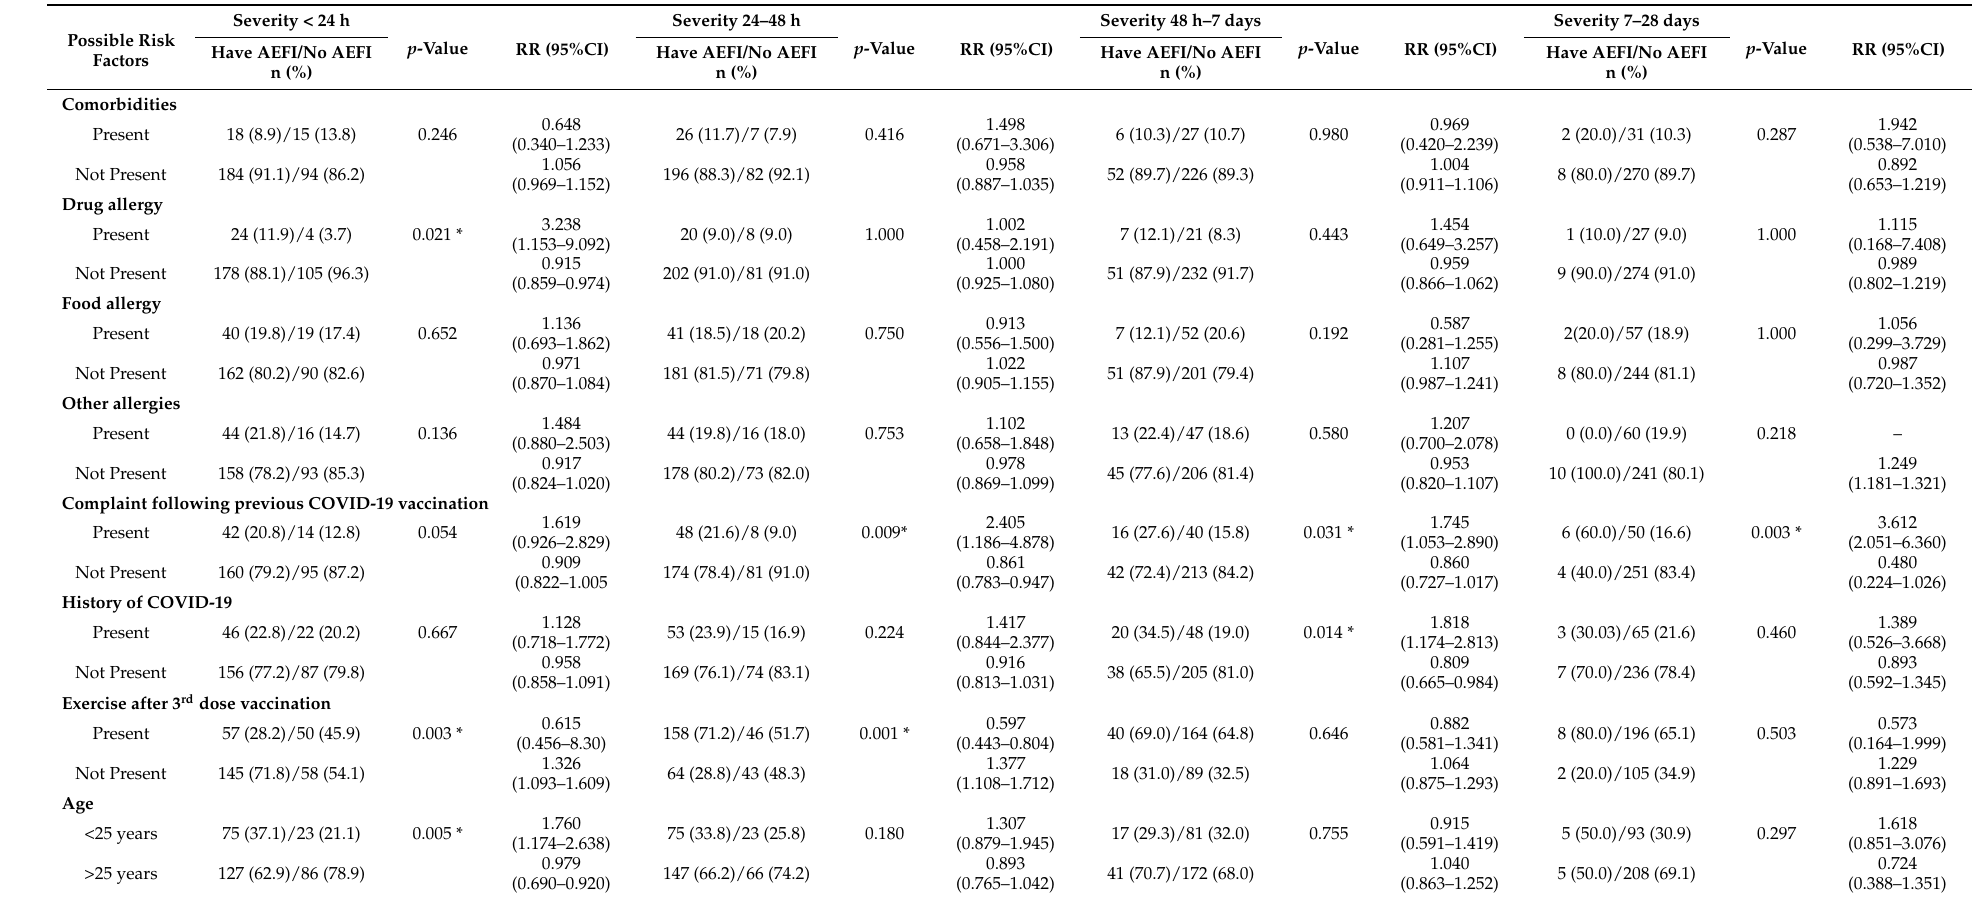
Table 3. Factors influencing AEFI in <24 h; 24–48 h; 48 h–7 days; and 7–28